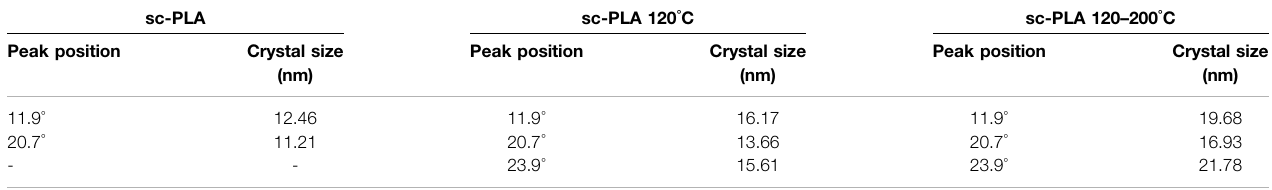
TABLE 2 | Crystal sizes of different polymers. sc-PLA